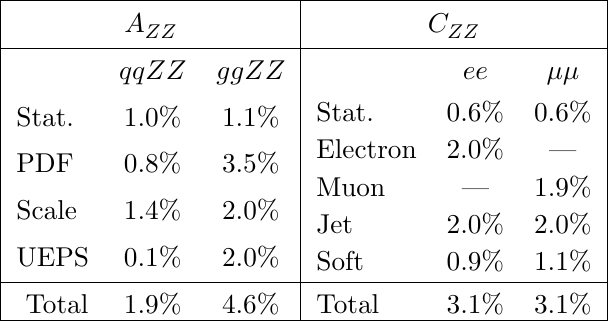
for the qqZZ ZZ for the ee and ZZ soft-term T